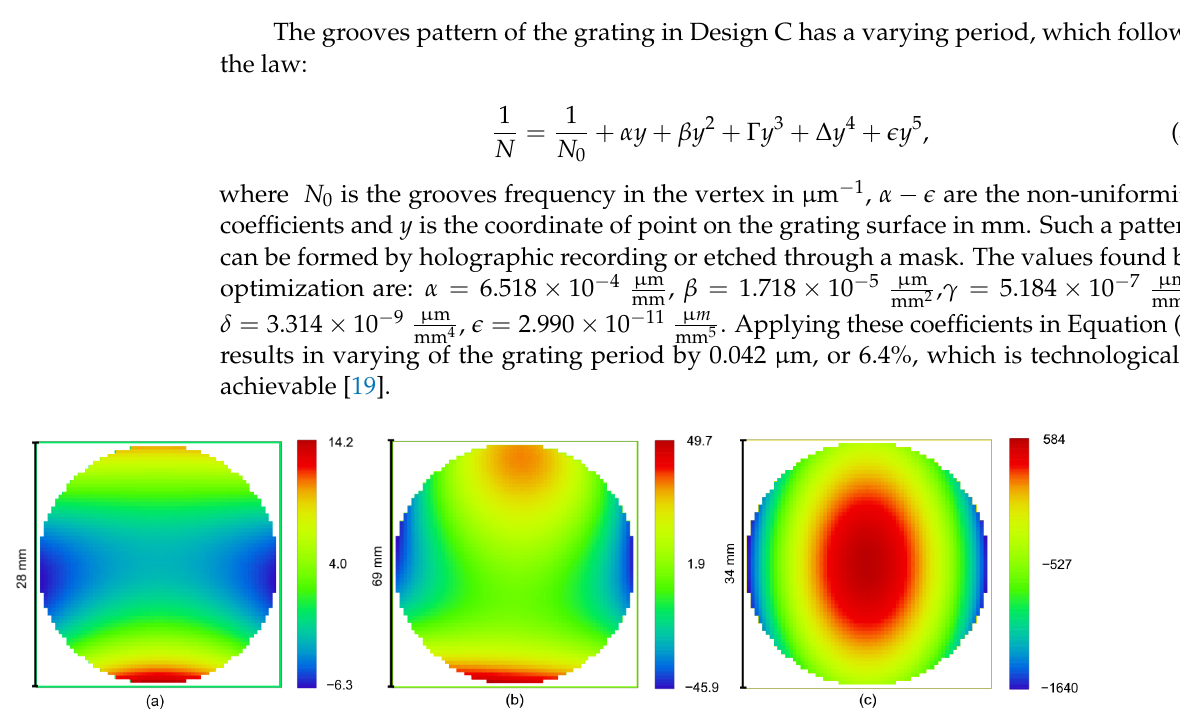
Figure 12. Deviation from the best fit sphere (in microns) of the freeform mirrors surfaces. Table 3. Freefrom mirros asphericity